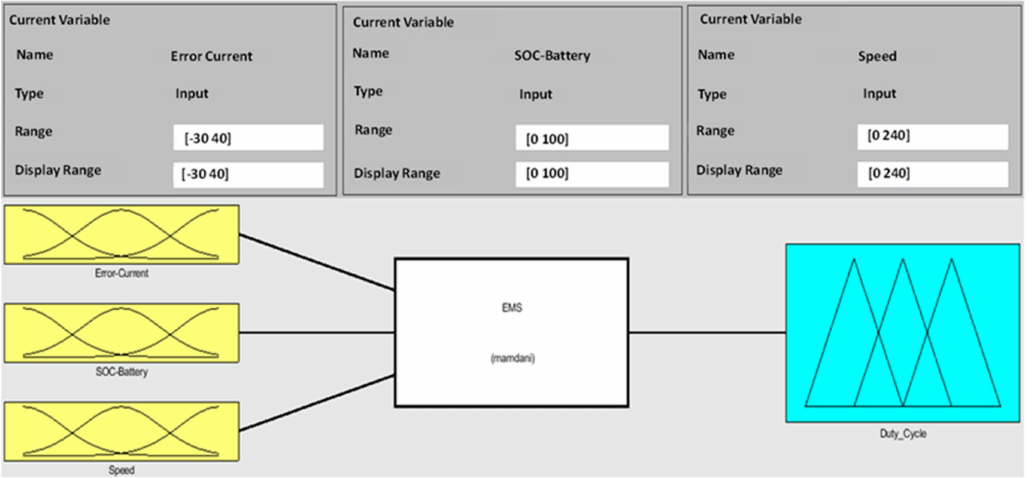
Figure 7. Fuzzy logic duty cycle controller.